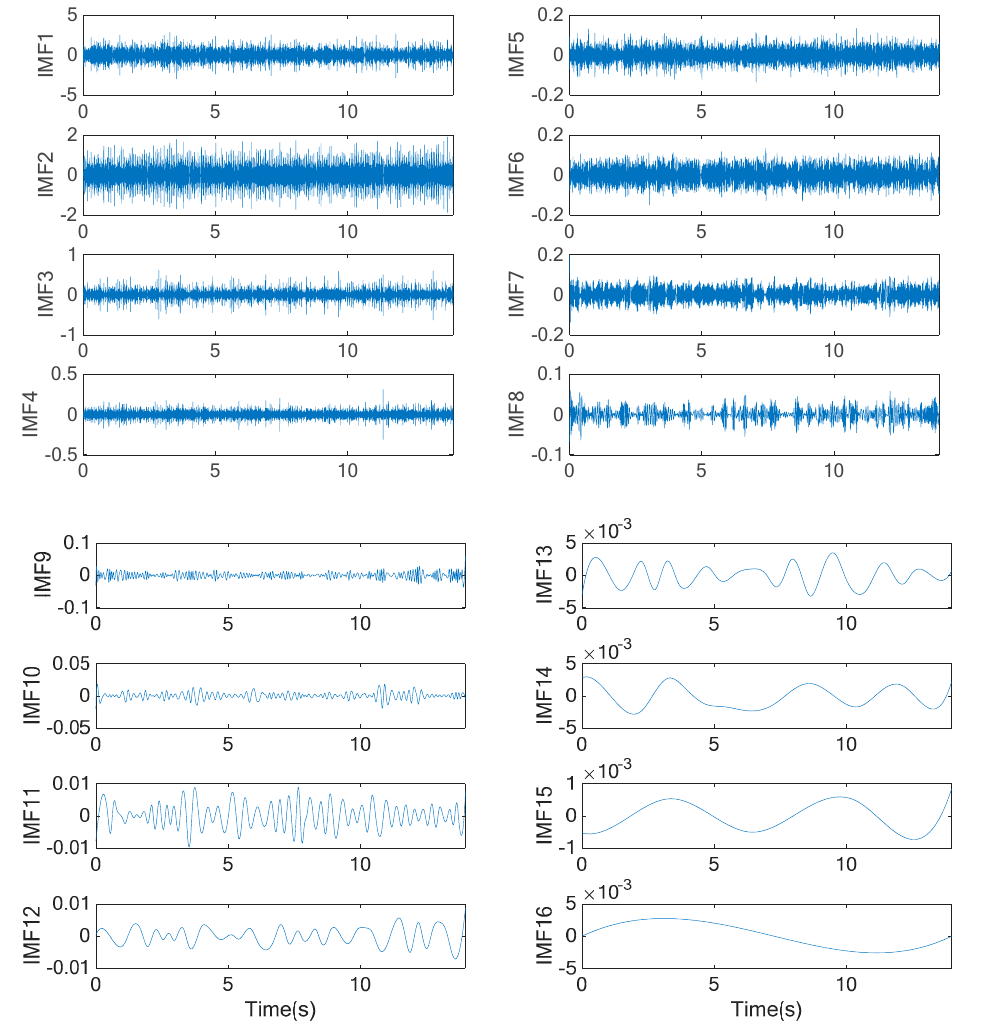
Figure 2. Illustration of vibration signal intrinsic mode functions (IMFs) through empirical mode decomposition (EMD).